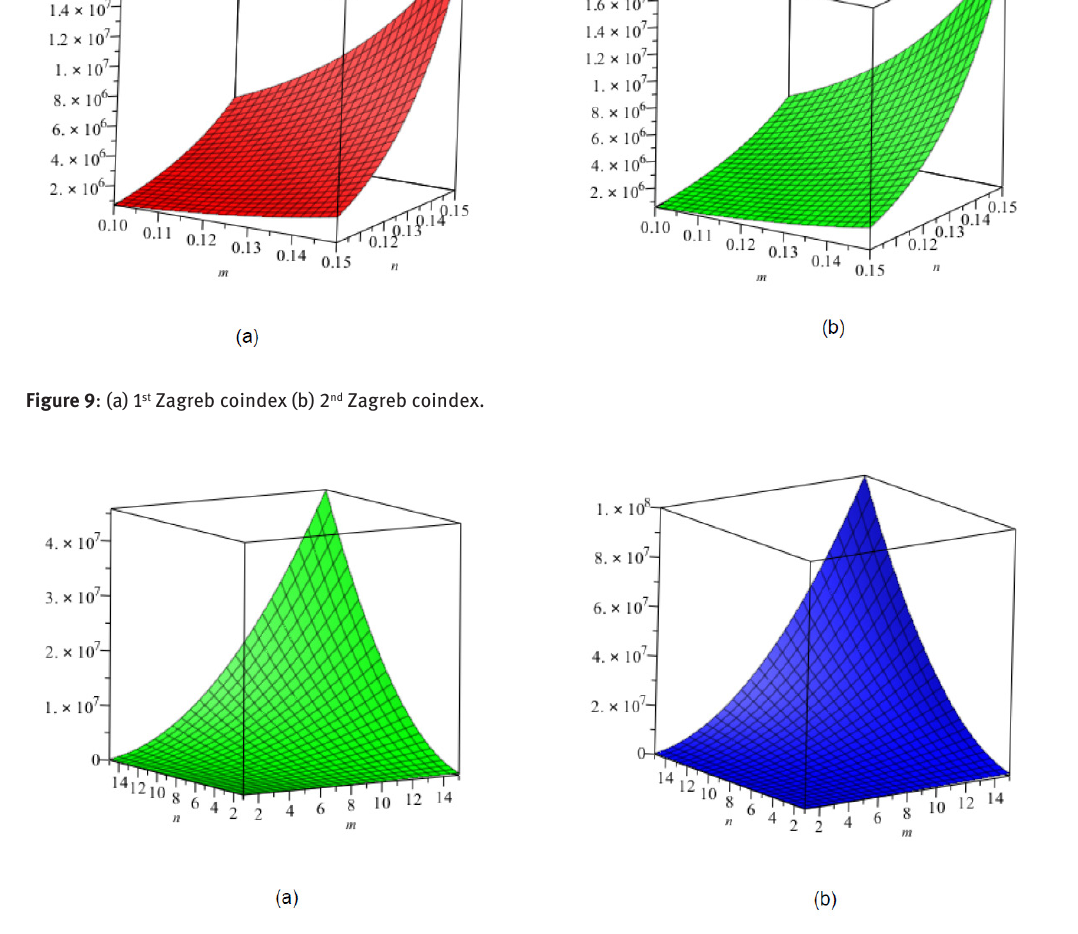
Figure 10 : (a) 1 st Multiple Zagreb index (b) 2 nd Multiple Zagreb index